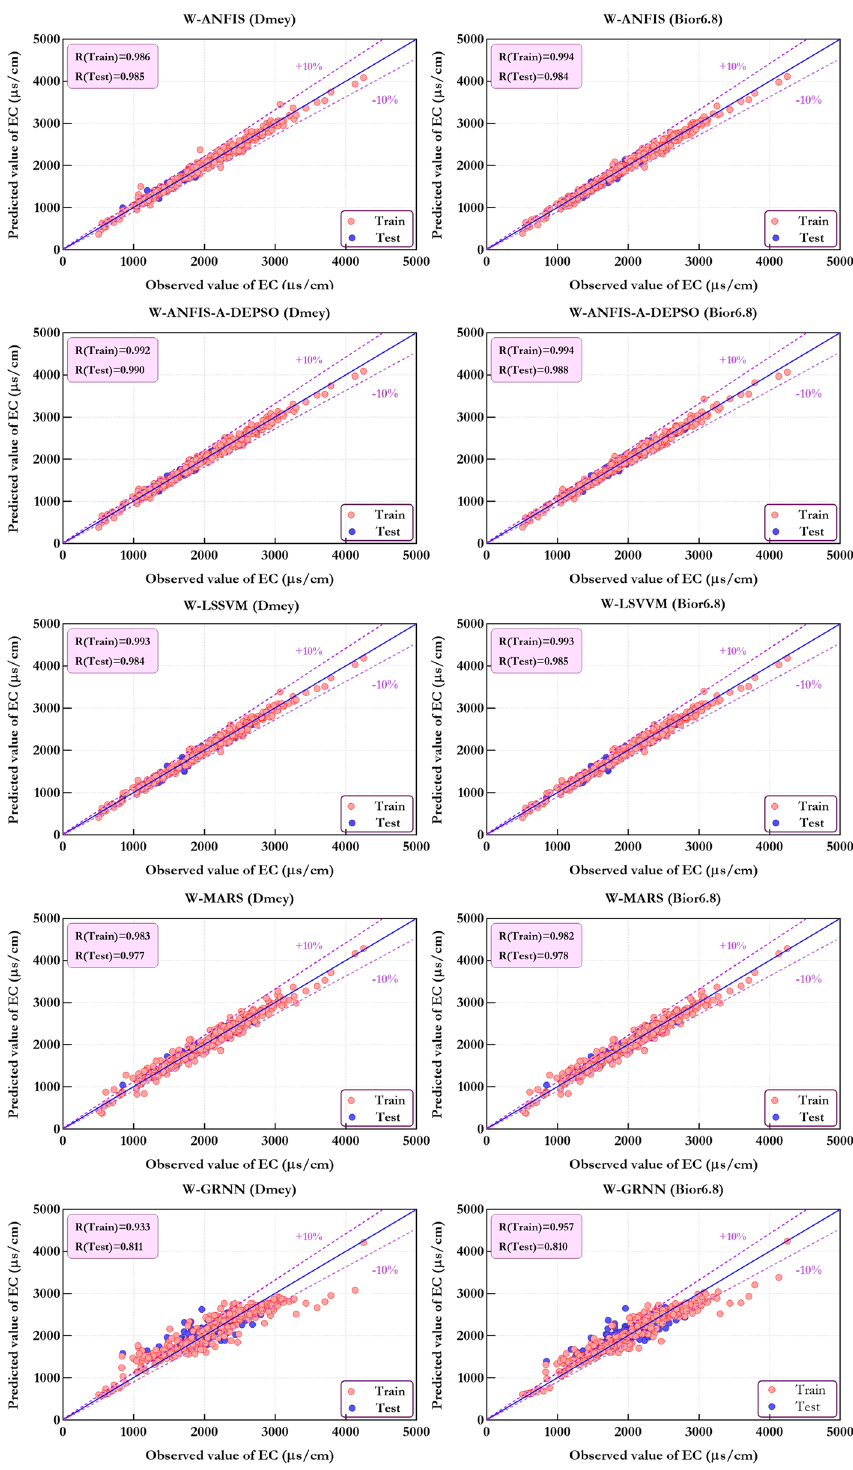
Figure 12. Compare estimated and measured values of EC utilizing the W-ML models in the form of a scatter